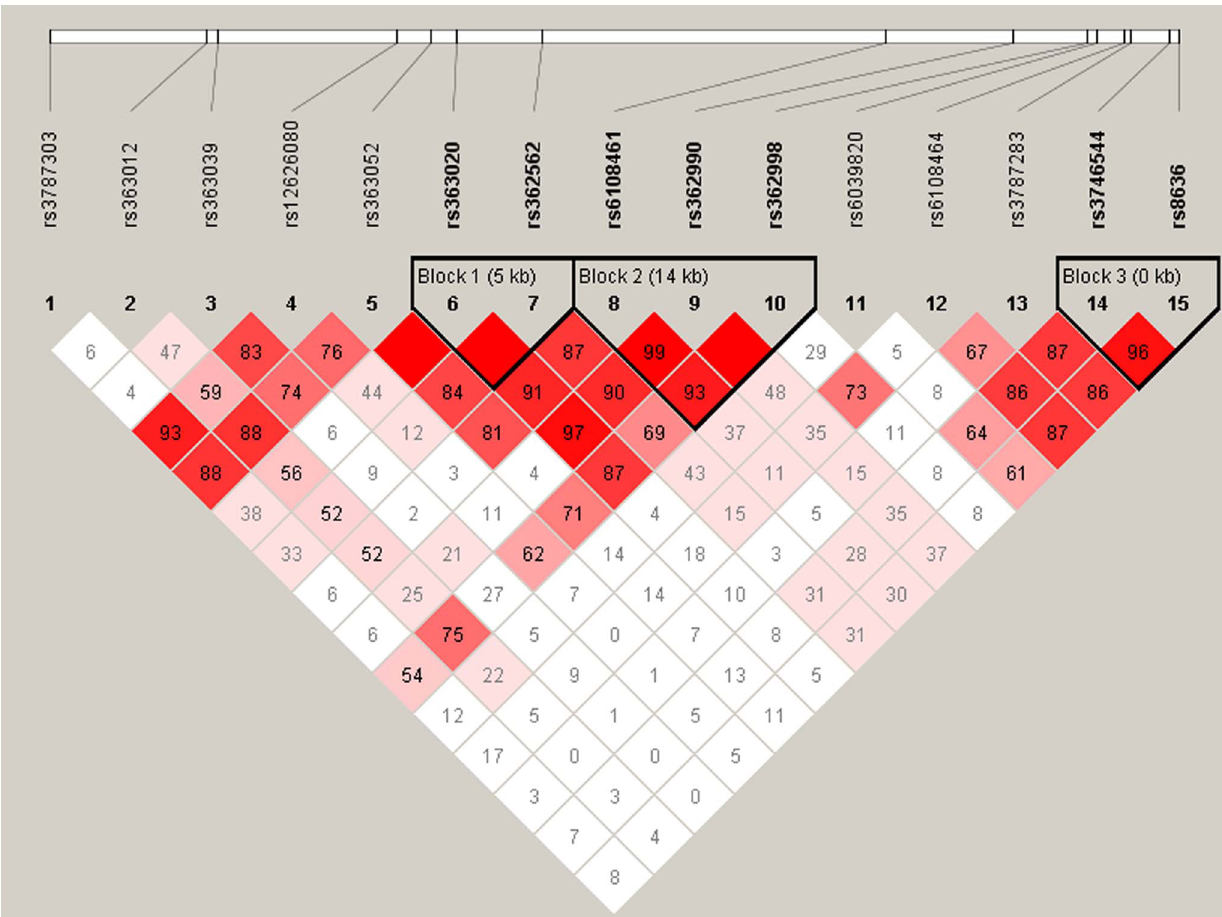
Figure 1. Linkage disequilibrium relation (expressed as D 9 values) of snap25 examined SNPs.